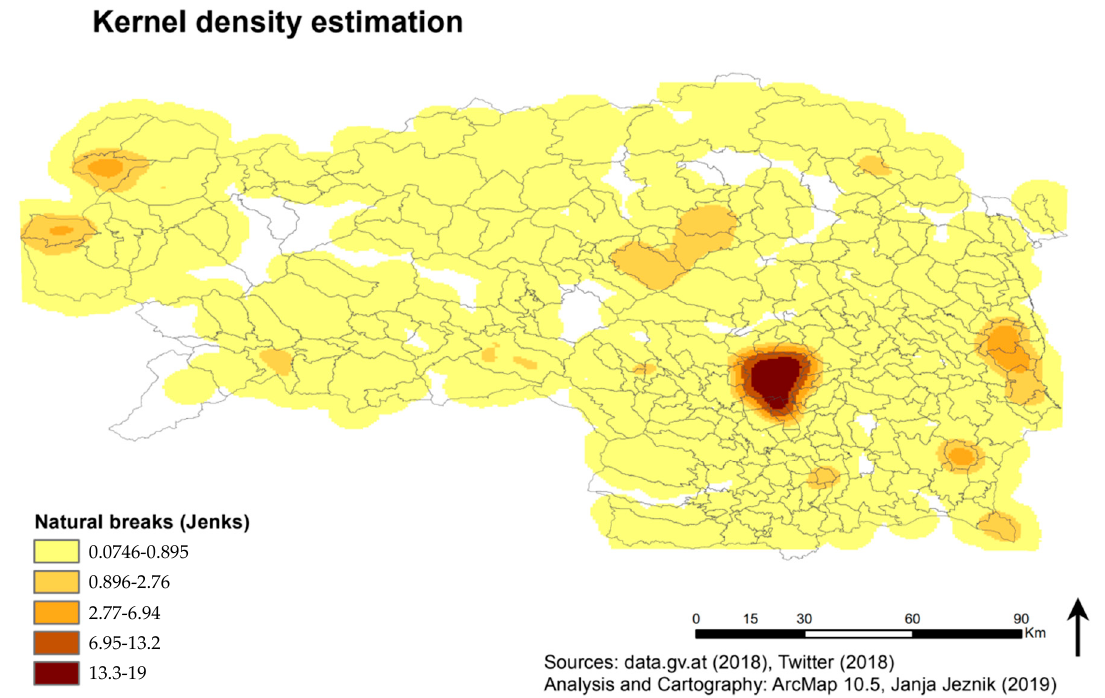
Figure 8. Results of the Kernel Density Estimation with a search radius of 5 km and an output cell size of 500 m. The resulting densities are classified using Jenk’s Natural Breaks method. The over-representation of the city of Graz, in comparison with the mostly rural area is visible.